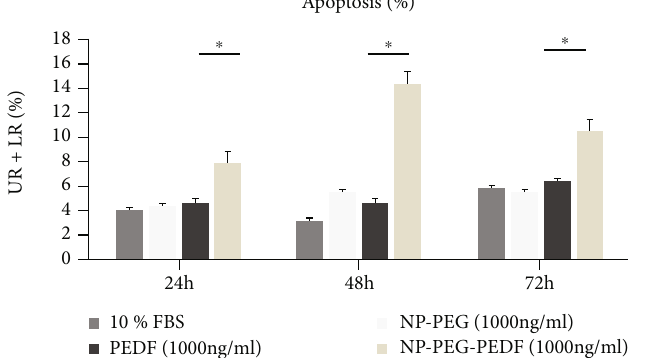
Figure 4: E ff ects of PEDF and NP-PEG-PEDF on HUVEC apoptosis under high glucose (30 mmol/L). DMEM+10% FBS control was set to 100%. ∗ p < 0 : 05